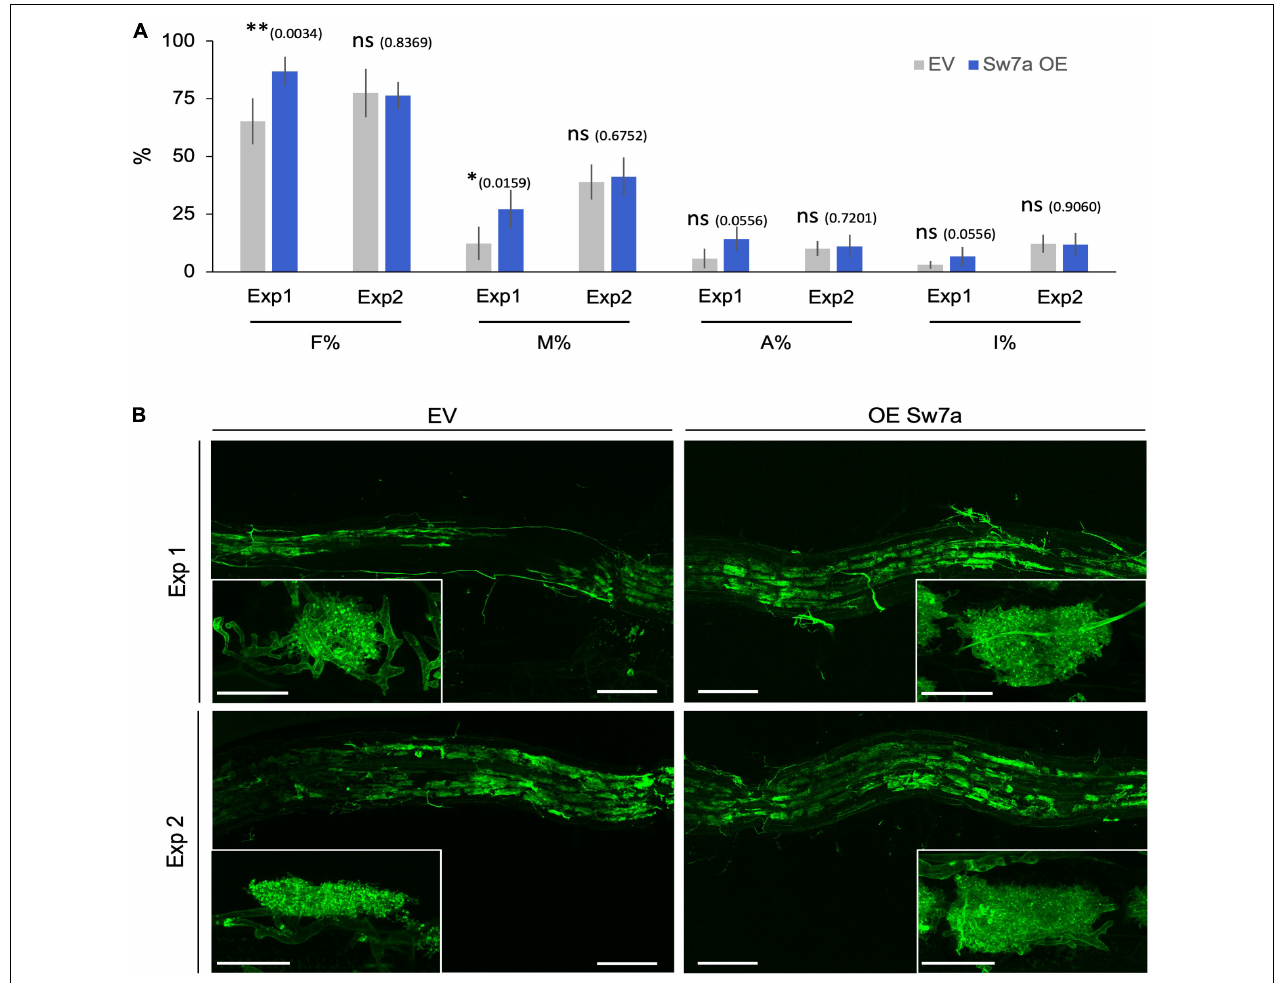
FIGURE 5 | Ectopic expression of StSWEET7a modifies root colonization when shoot is intact. (A) Quantification of R. irregularis colonization was carried according to Trouvelot et al. (1986). F% represents the frequency of mycorrhization, M% the intensity of colonization, A% the abundance of arbuscules, and I% the abundance of hyphae in the root system. Five biological replicates ( n = 5) were used for each treatment. Statistical significance (calculated as explained in section “Materials and Methods”) is shown with exact p -values and with asterisks, ns, non-significant, p > 0.05; ∗ p < 0.05; ∗∗ p < 0.01. (B) Representative pictures of the observed colonization in potato roots stained with WGA-FITC (green signal). Scale bars are 200 µ m for overview pictures and 30 µ m for pictures in inlets depicting single